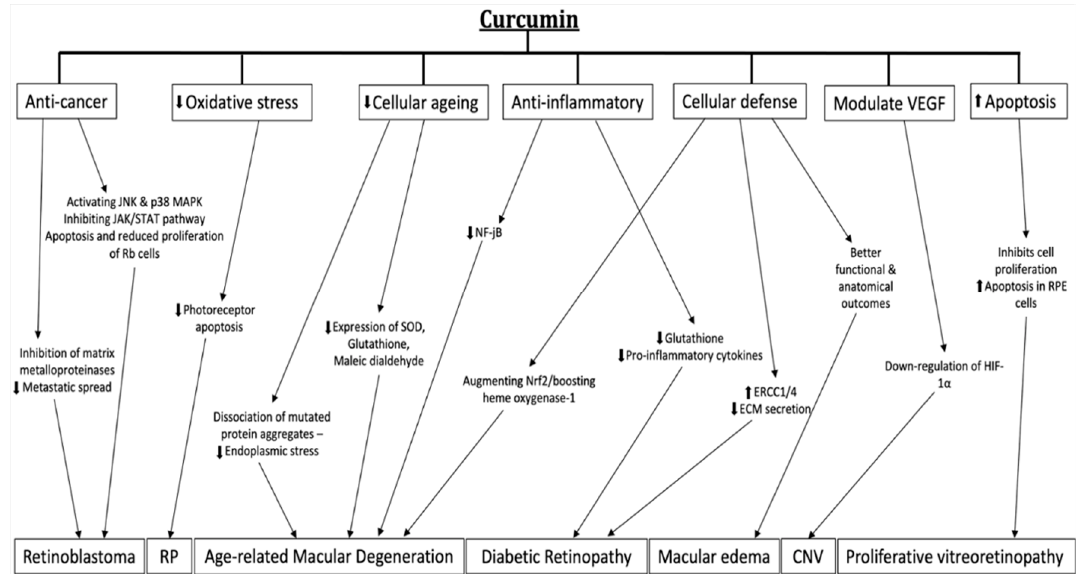
Figure 4. Schematic diagram reviewing curcumin mechanism of action in retinal diseases. Up arrow stands for augmentation, down arrow stands for reduction.